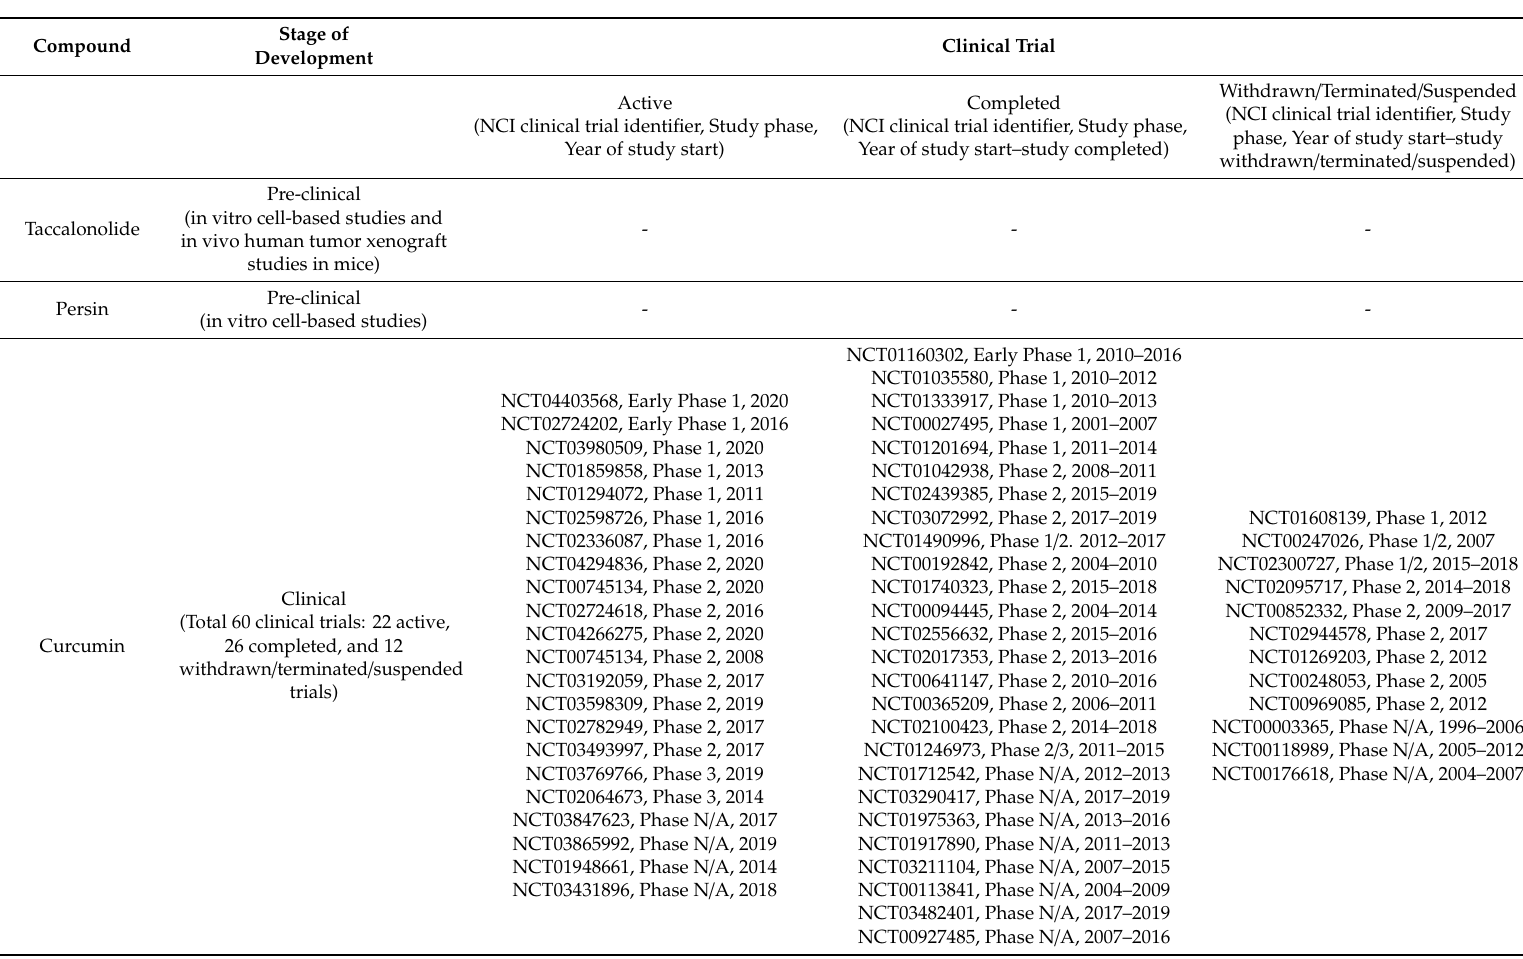
Table 2. The current stage of development and the clinical trial information of taccalonolide, persin, curcumin, combretastatin, noscapine, maytansinoids, chalcones, and quercetin. The clinical trial information was obtained from the NIH ClinicalTrials.gov (https: // clinicaltrials.gov / ) by using the search criteria “cancer” and the “compound name” in the database. N / A indicates not